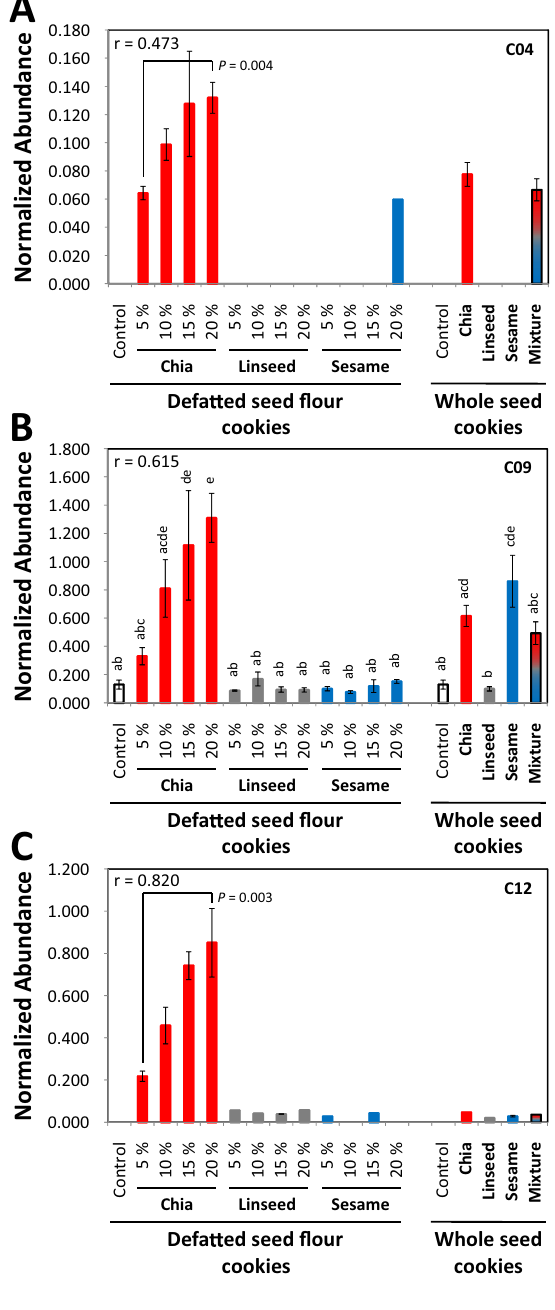
Figure 7. Characterization of chia seed identity markers in experimental bakery products. Non-targeted metabolite profiling analyses of polar extracts were generated from experimental cookies that were prepared, left to right, with 5, 10, 15, or 20% (w/w) defatted seed flour of single seed types, 15 ± 5% (w/w) whole seeds of single seed types, or an equal (w/w/w) mixture of whole seeds. Inserts show the Pearson’s correlation coefficients of weight percentage of the seed types and normalized abundance of marker compounds. Normalized abundances are means ± standard error (n = 4–5), bars without whiskers are single observations. ( A ) Compound C04: 4-hydroxybenzaldehyde. ( B ) Compound C09: a tri-saccharide with best match to melezitose. ( C ) Compound C12: a monomethylinositol with best mass spectral match to pinitol. Tukey’s test